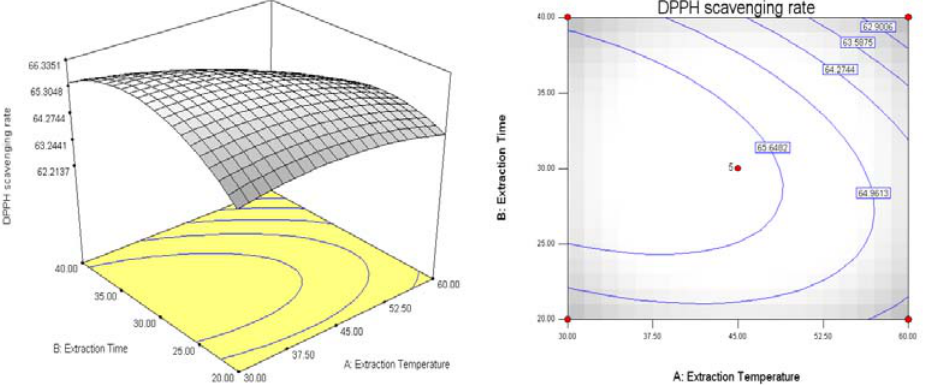
Figure 4. Response surfaces and contour plots showing the effects of extraction temperature and extraction time on antioxidant activity Y = (A, B).